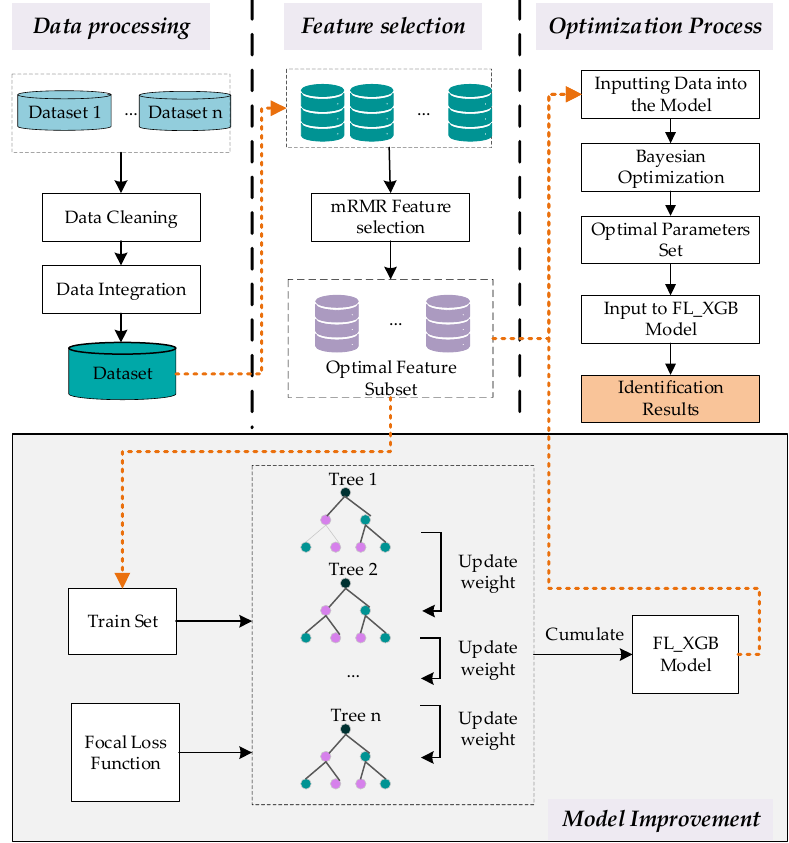
Figure 1. FL_XGB-VPN-encrypted traffic identification model general framework.